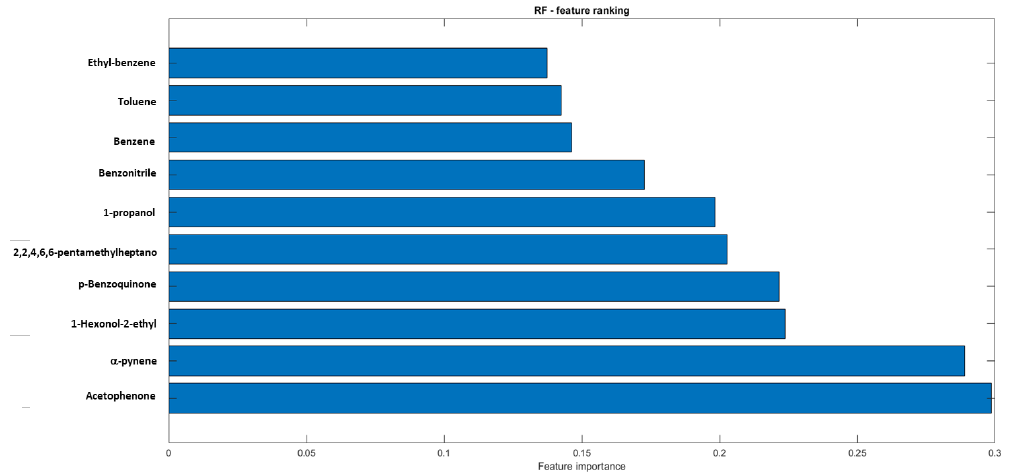
Figure 4. The first 10 ranked features of the RF classifier.